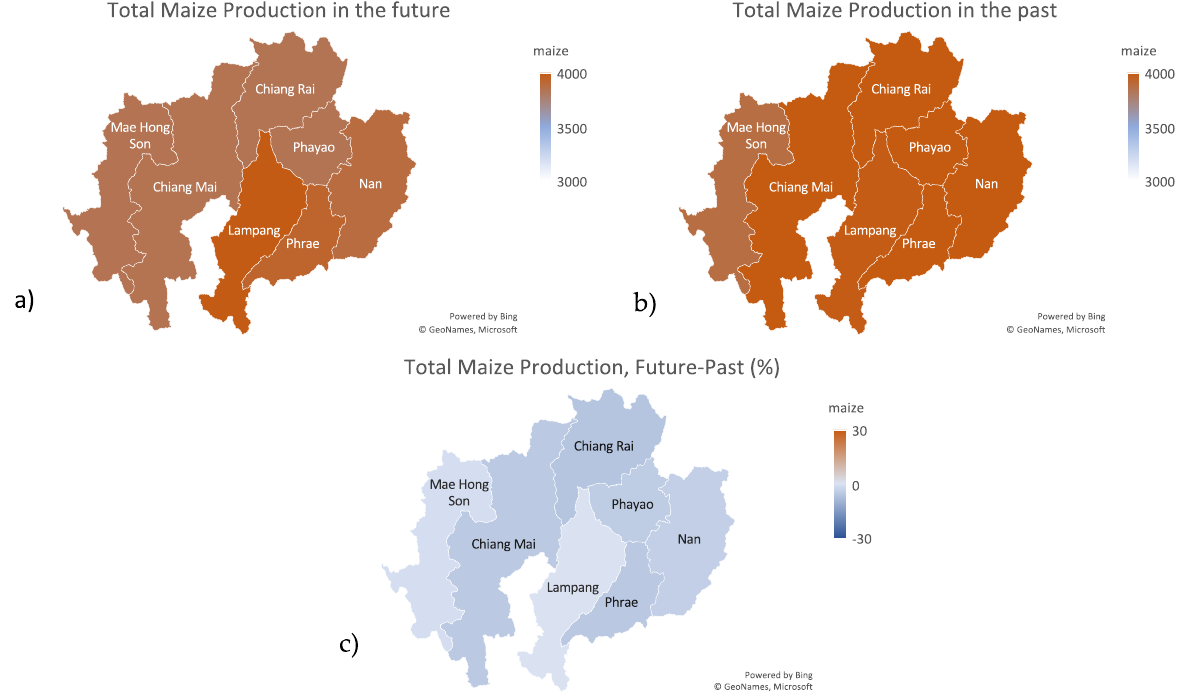
Figure 5. Average maize production during ( a ) 2020–2029 and ( b ) 2010–2018, and ( c ) the difference between 2020–2029 and 2010– 2018.